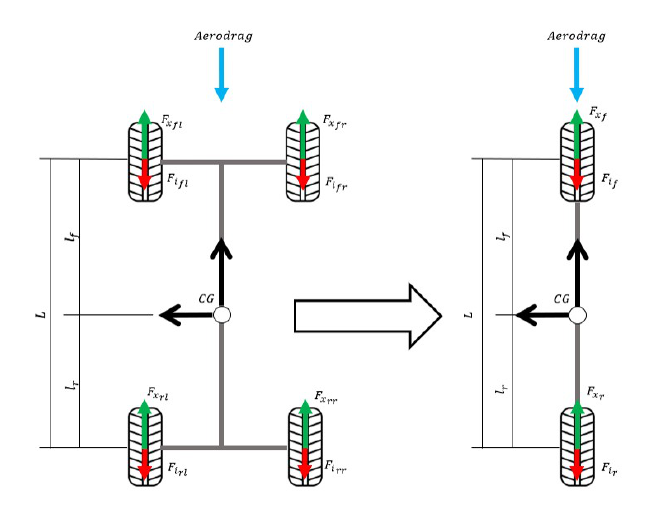
Figure 2. Friction Estimator: Vehicle model and reference system in which the z axis is perpendicular to the road equivalent plane xy